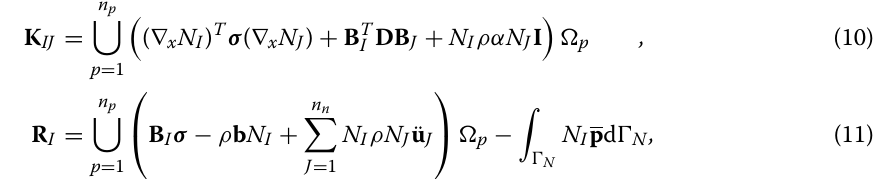
Fig. 1 General workflow of MPM: (I) Initialization phase, (II) Lagrangian phase and (III) Convective phase and J of the background grid element, as well as the residual force vector components, related to the respective background grid node I , can be obtained